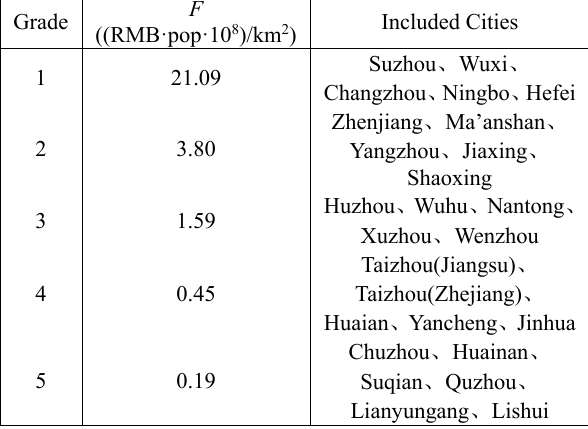
Table 3. Classification result according to spatial interaction intensity